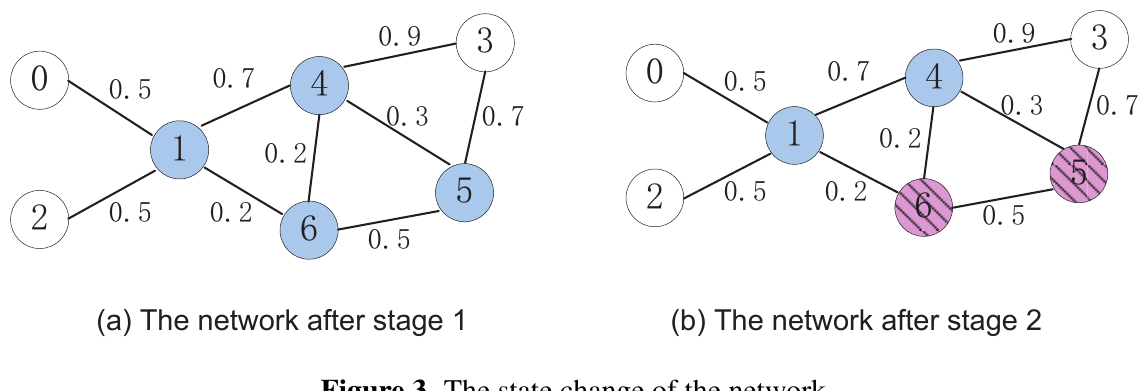
Figure 3. The state change of the